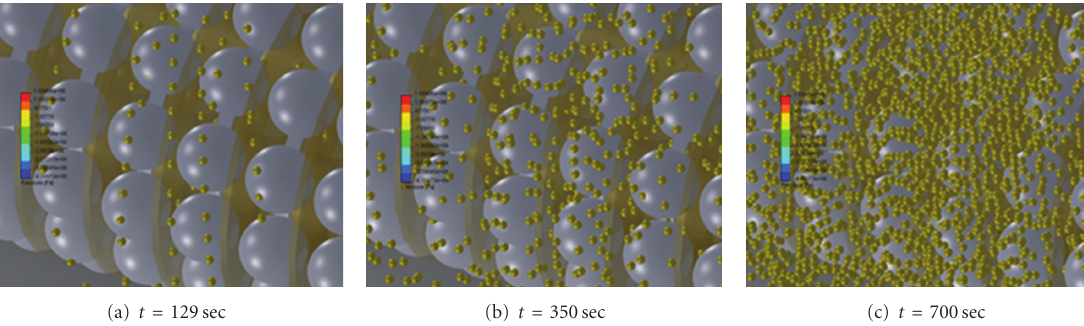
(b) and (c) at di ff erent times of the adsorption of the beds t = 129 sec, t = 350 sec, and t = 700 sec [1, 7,